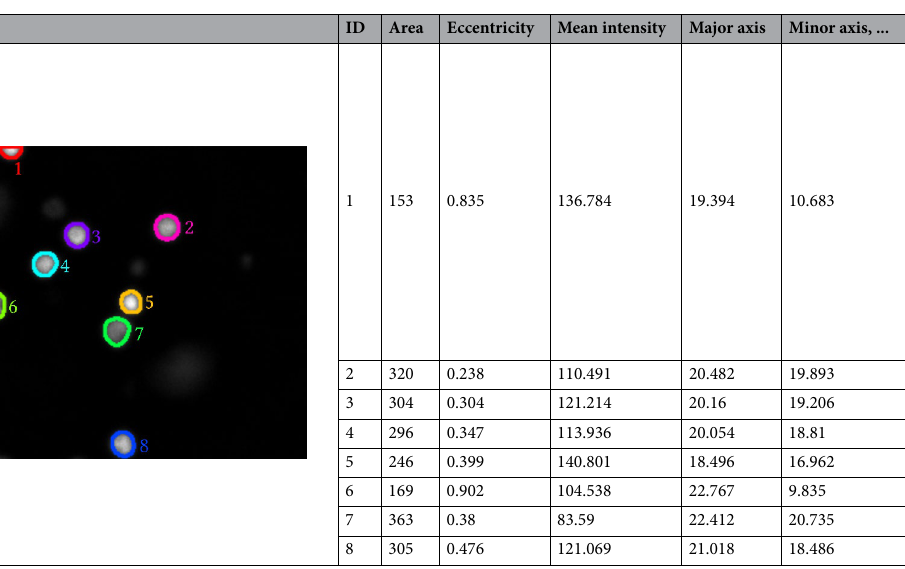
Table 2. List of features. The exemplary features (area, eccentricity, mean gray value, major axis/minor axis lengths) extracted per instance are shown.